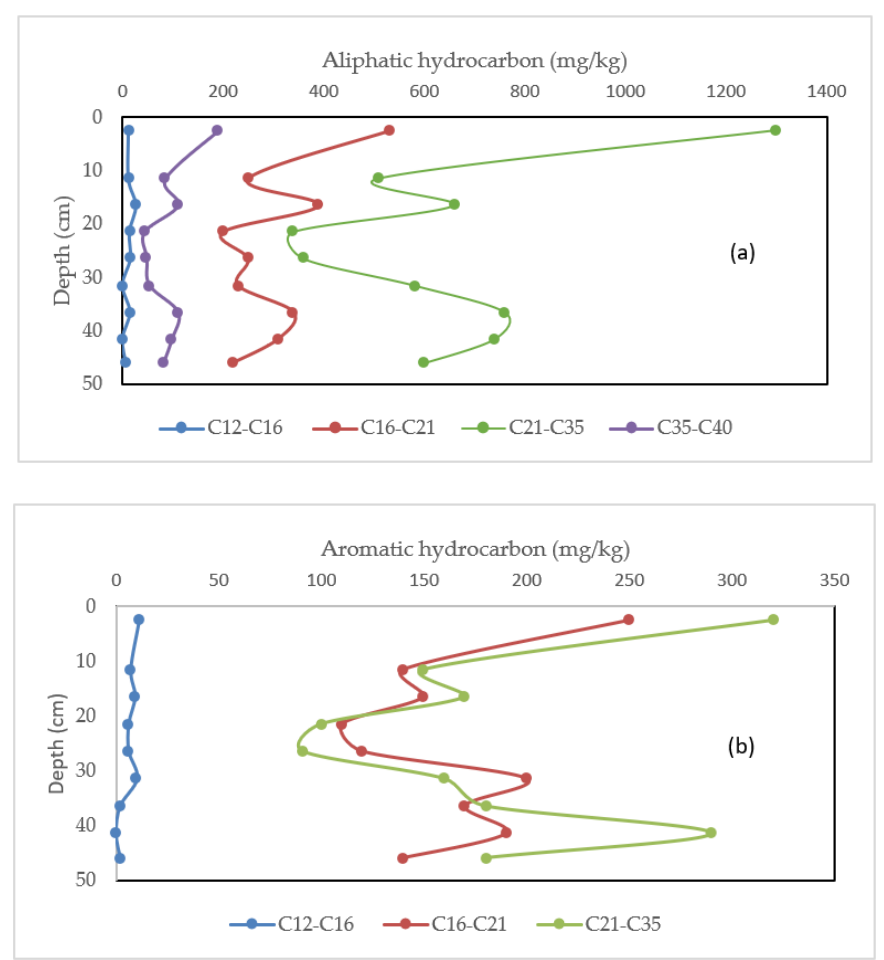
Figure 5. Changes in various ( a ) aliphatic hydrocarbon fractions and ( b ) aromatic hydrocarbon fractions along soil profile 16.